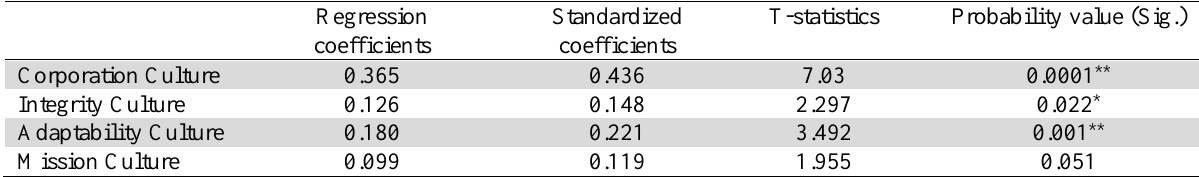
Regression between organizational culture components and organizational success